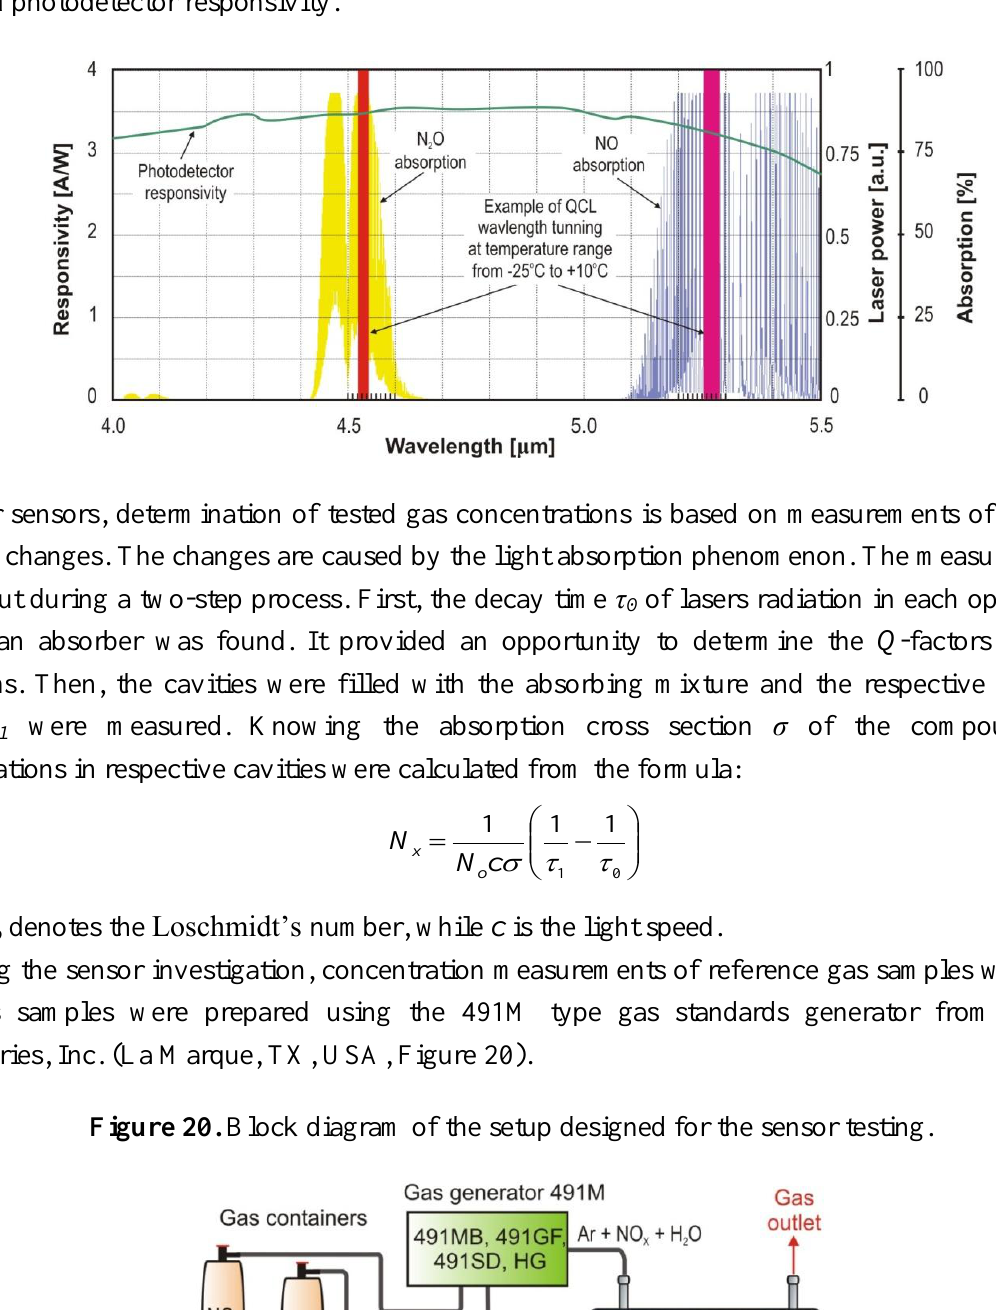
O and NO absorption lines 2